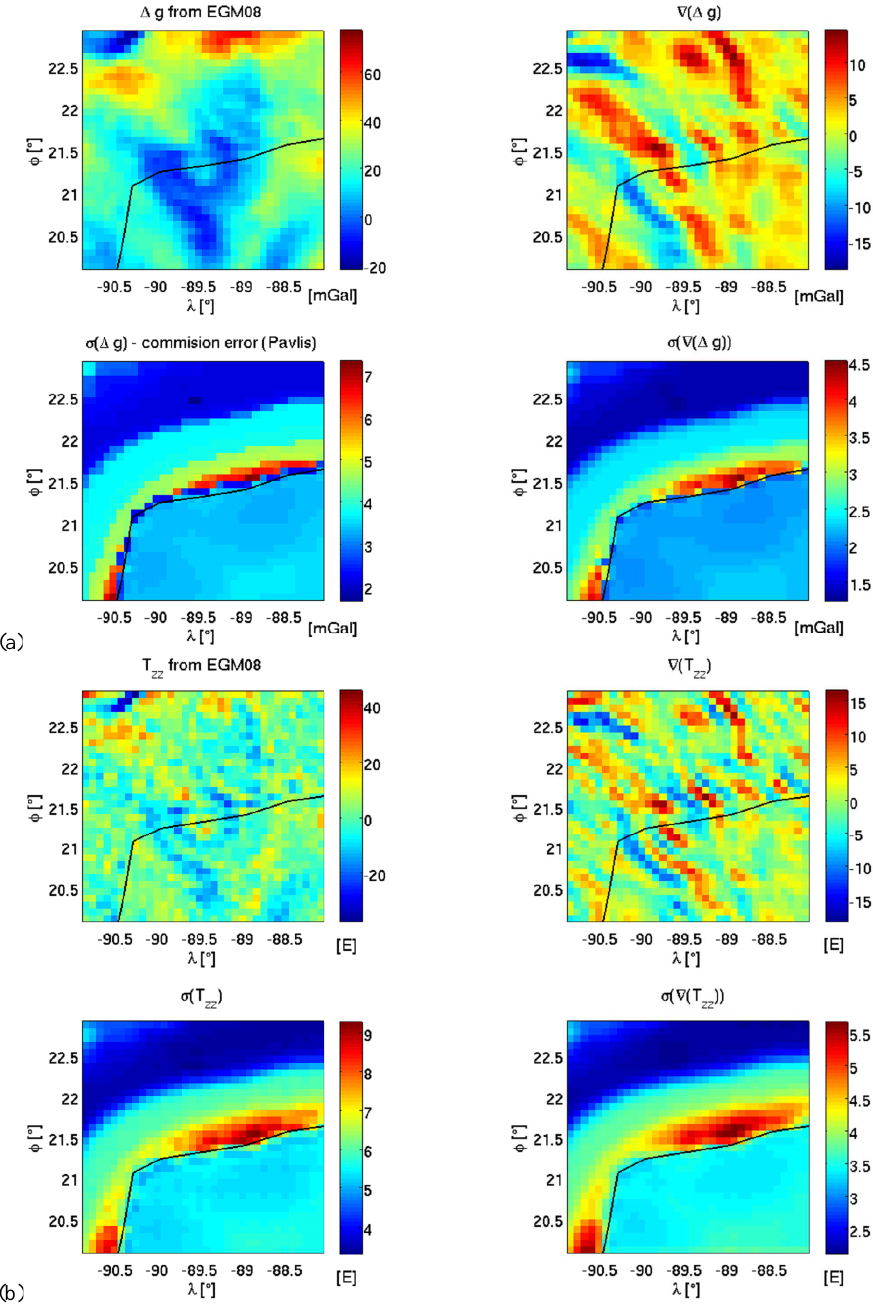
Fig. 8. (a) : Comparison of the gravity anomaly 1g (upper left) and its gradient (upper right) with relevant σ (1g) (lower left) and σ( grad (1g)) (lower right) for Chicxulub. (b) : Comparison of the second radial derivative T rr (upper left) and its gradient (upper right) with relevant σ (T rr ) (lower left) and σ ( grad (T rr )) (lower right) for